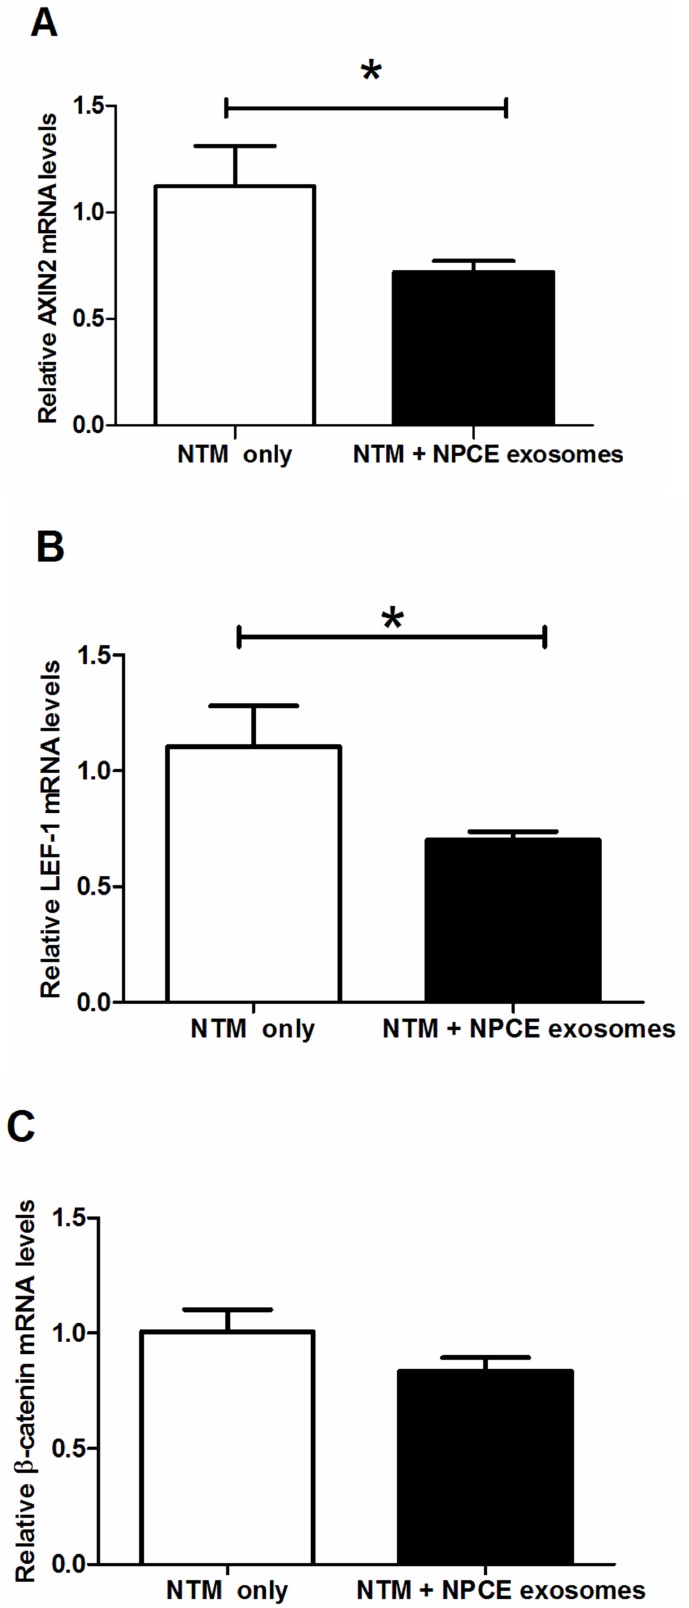
Real-time qRT-PCR was performed to examine the mRNA expression levels (mean ± sem) of canonical WNT/β-CATENIN signaling components, including the Wnt transducers Axin2 (A), β-catenin (C), and the Wnt transcription factors LEF1 (B).Data were normalized to the average mRNA level of GADPH. Statistical difference is indicated by asterisks (*P < 0.05,).